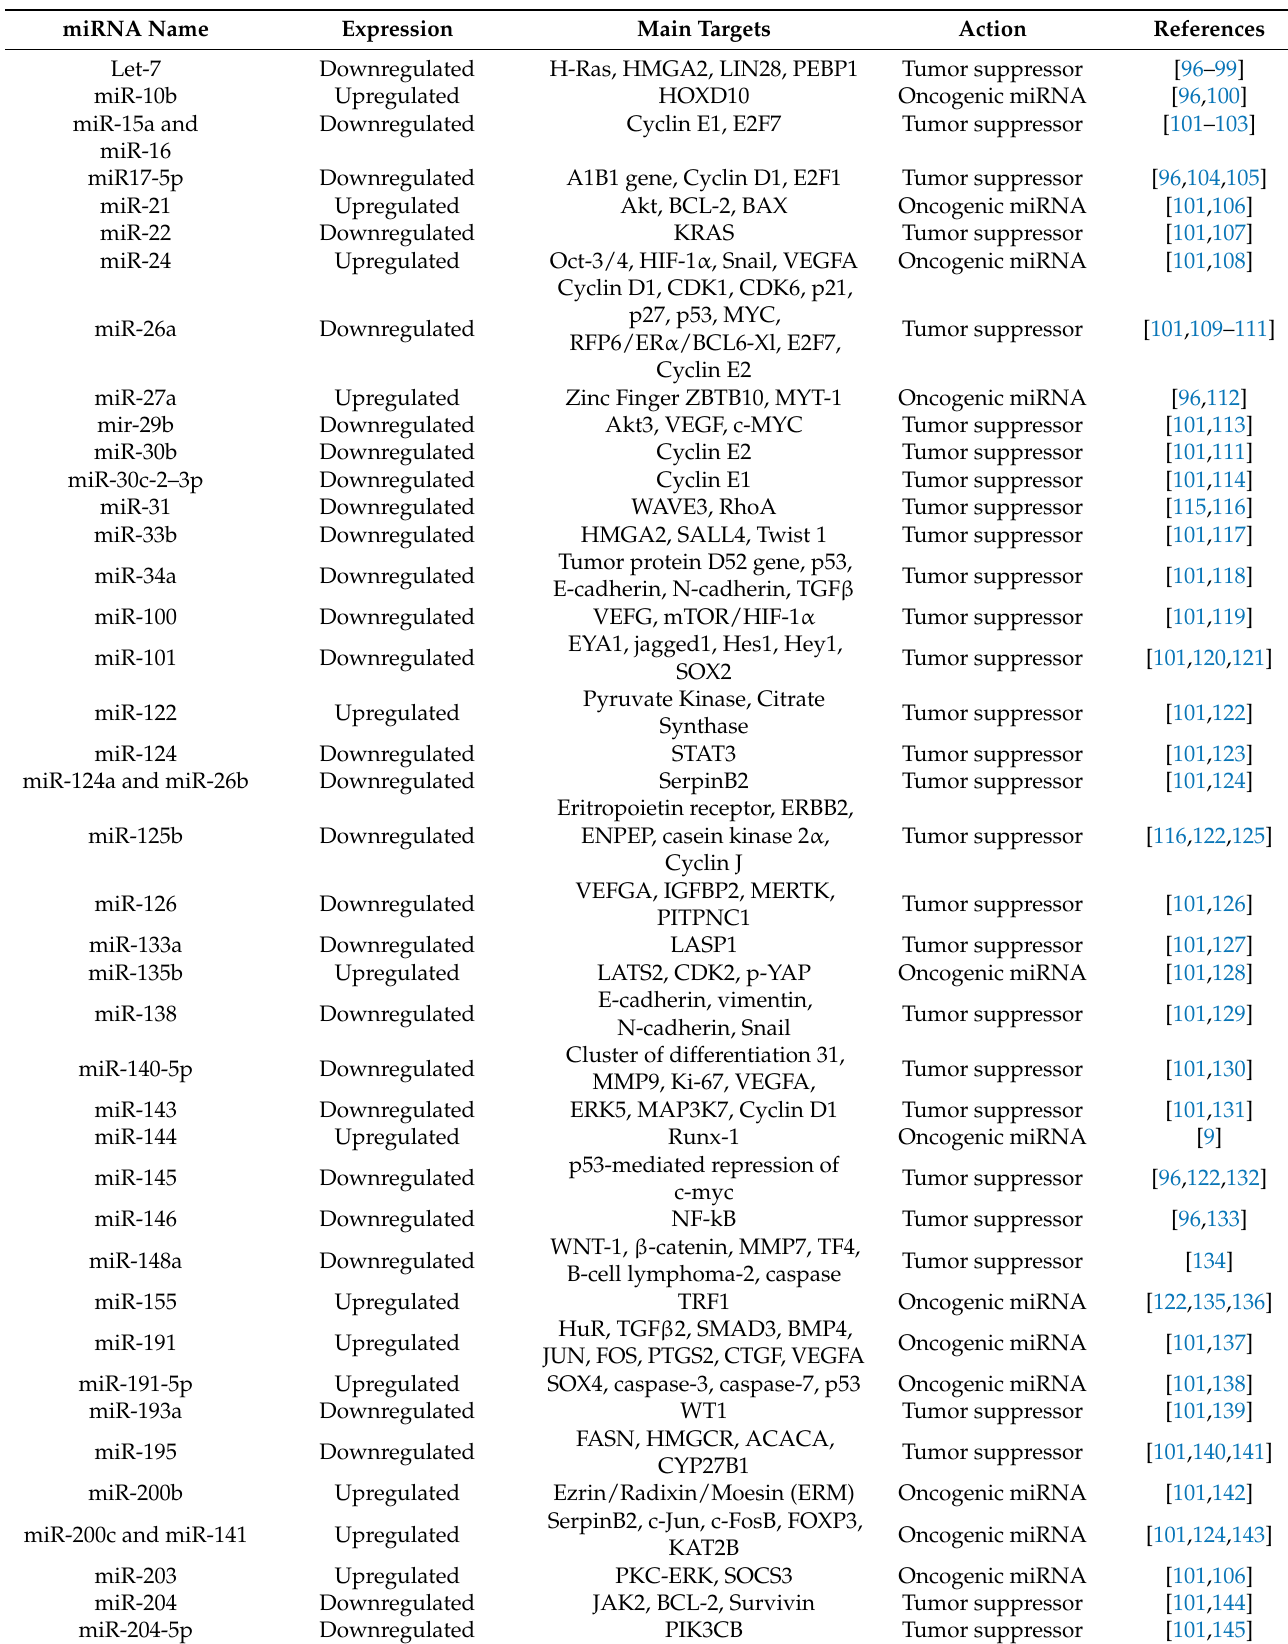
Table 1. Main miRNAs modulated in breast